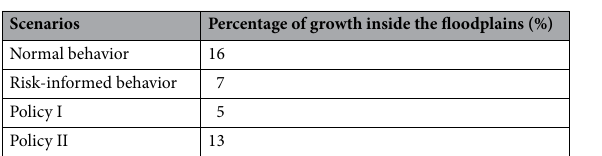
Scenarios Percentage of growth inside the floodplains